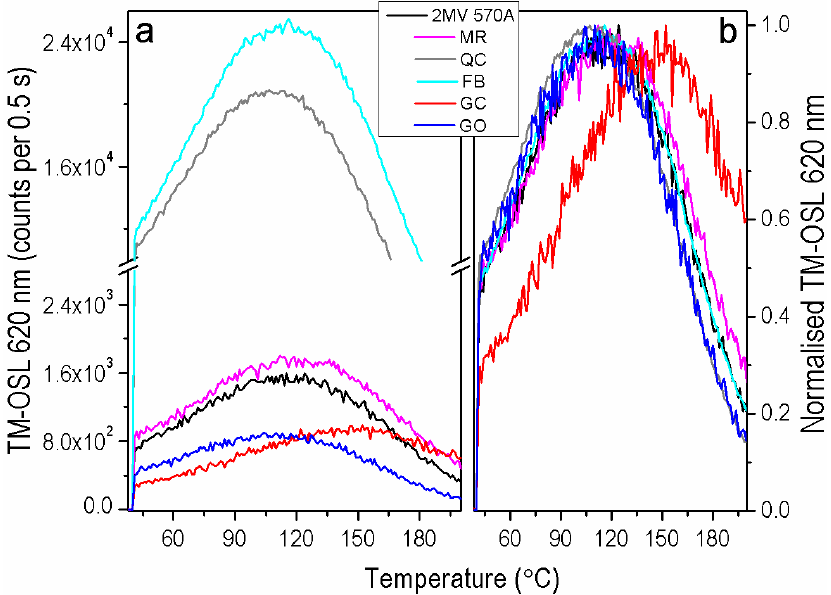
Figure 3. ( a ) TM-OSL 620 nm curves measured for one aliquot of each sample after irradiation with a dose of 1000 Gy and preheat up to 280 °C, ( b ) the same data set normalized to the curve maximum. TM-OSL signals were measured after irradiation and preheat up to 280 °C with a heating rate of 2 Ks − 1 . During linear heating with a rate of 2 Ks − 1 , the optical stimulation was carried out using 620 nm LEDs with power ~33 mW/cm 2 .